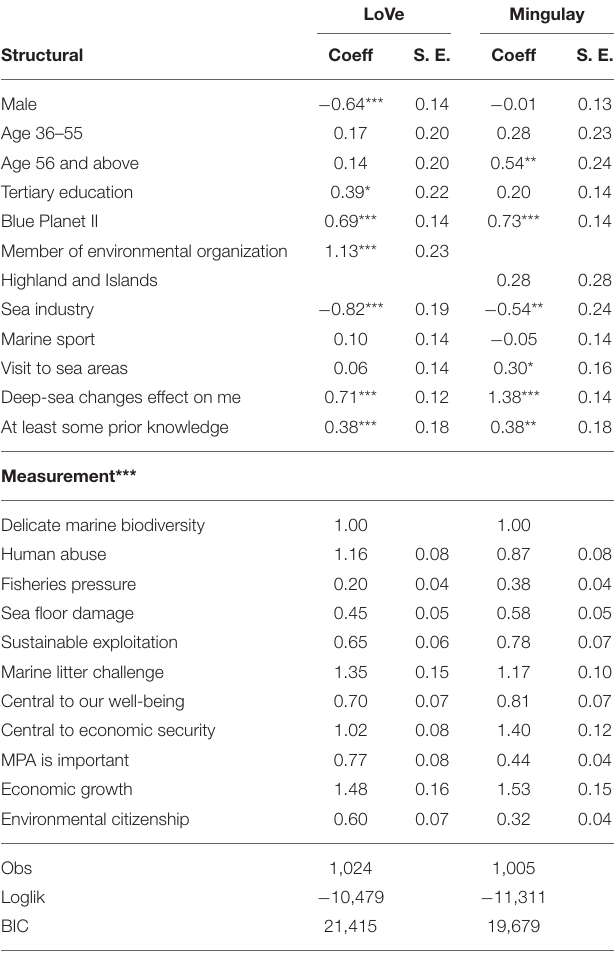
TABLE 6 | MIMIC GSEM: Influencers of pro-marine environmental